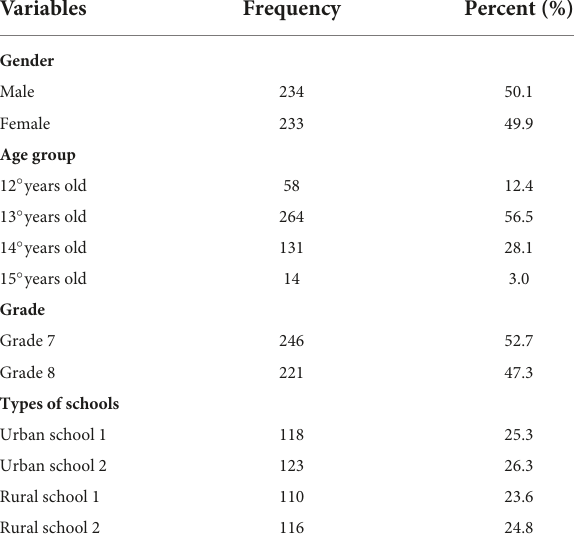
TABLE 1 Demographic statistics ( N =